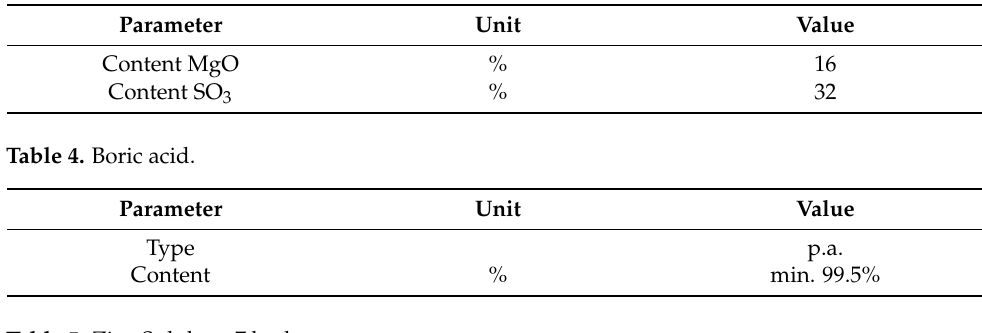
Table 5. Zinc Sulphate 7 hydrate.